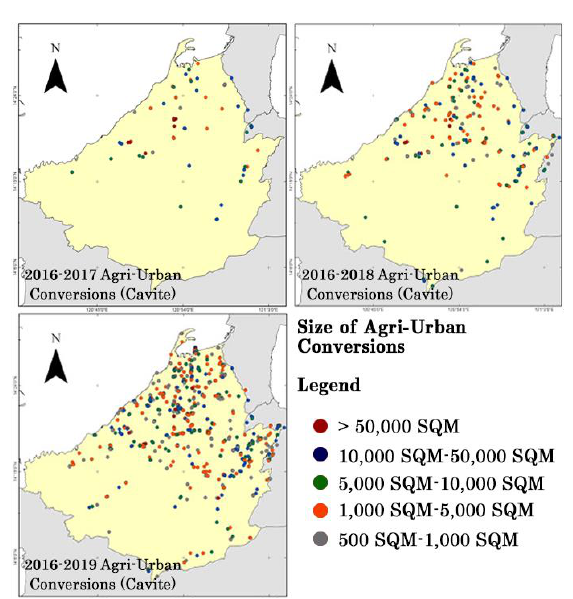
Figure 4. LULC change maps of Cavite from 2016 to 2017, 2016 to 2018, and 2016 to 2019.